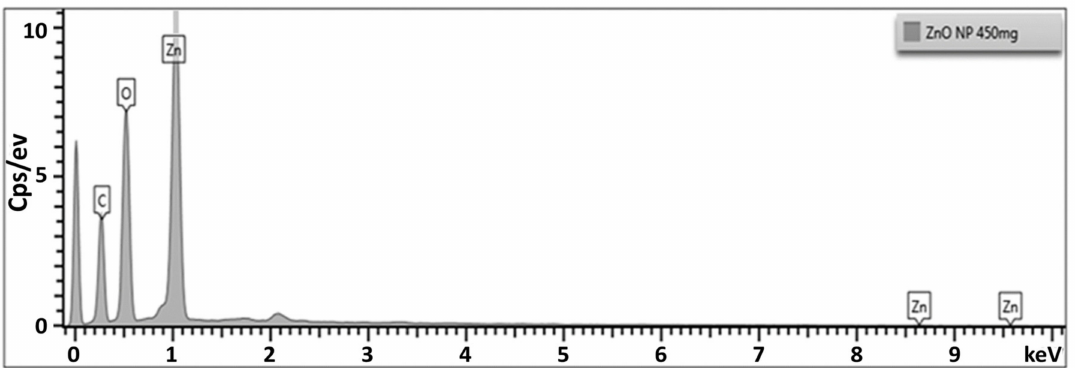
Figure 5. ZnPs EDX